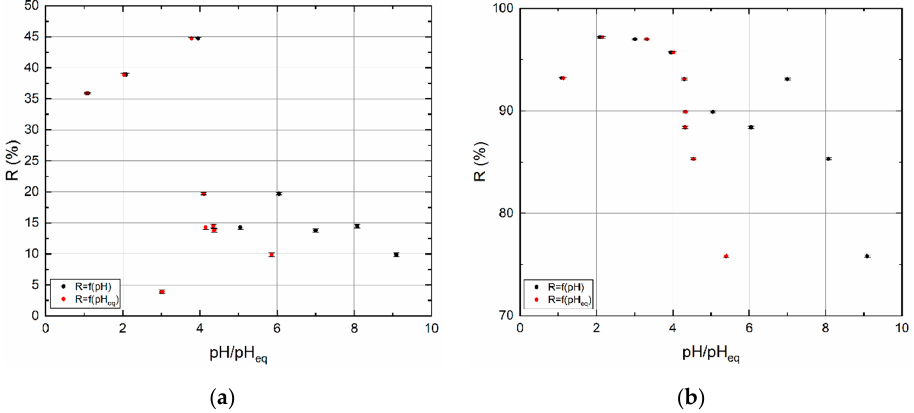
= 24 h. eq. ( a ) BC1, and ( b ) BC2a. t